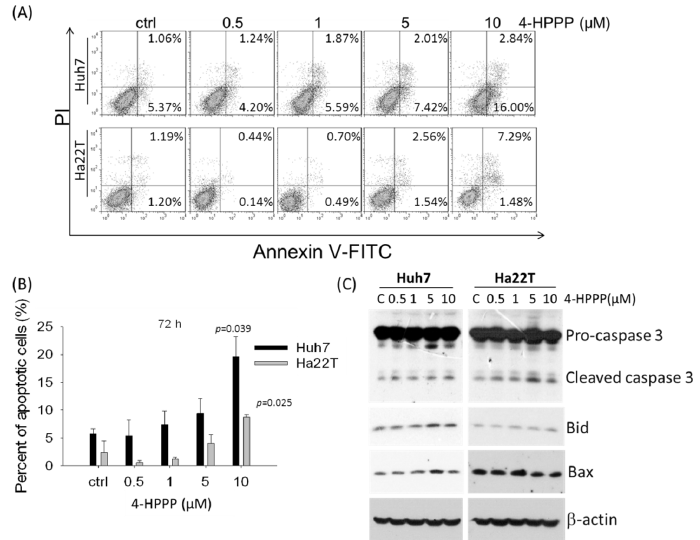
Figure 6. The assessment of 4-HPPP-induced apoptosis in HCC cells. Flow cytometry-based annexin V staining for detecting apoptosis. ( A ) Cells were treated with indicated concentrations of 4-HPPP for 72 h respectively. ( B ) The quantitative analysis of apoptotic cells of ( A ). p < 0.05 control vs. 4-HPPP was considered statistically significant. ( C ) The changes of pro-apoptotic factors including cleaved caspase-3, Bid and Bax in HCC cell lines following 4-HPPP treatment. β -actin as an internal control for ensuring equal